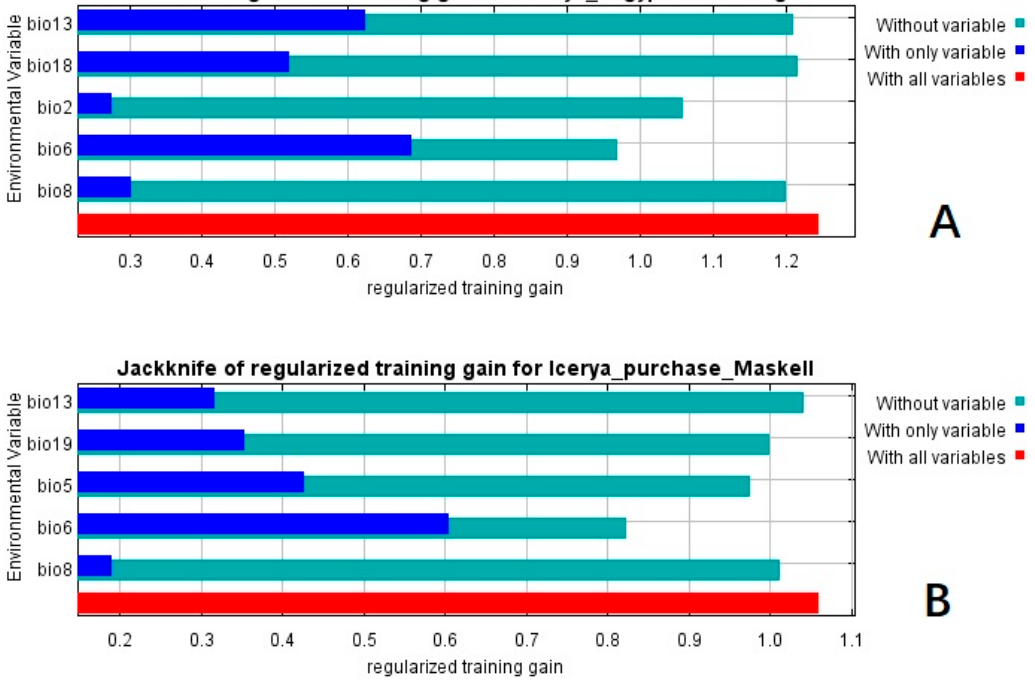
Figure 3. Importance of environmental variables in predicting the distribution of Icerya Signoret. ( A ) I. aegyptiaca ; ( B ) I. purchasi . “Without variable” represents the regularized training gain of the model without this variable, “With only variable” represents the regularized training gain of the model with only this variable.